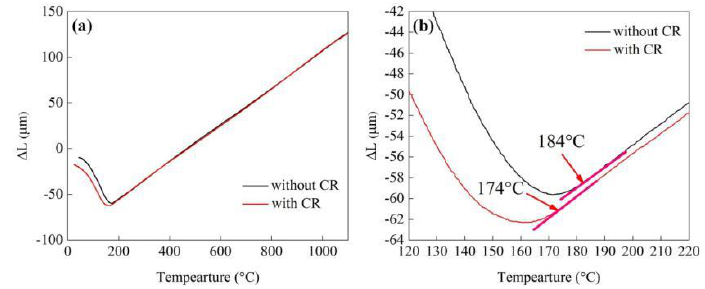
Figure 2. ( a ) Dilation versus temperature curves at the cooling rate of 10 °C/s; ( b ) magnification of ( a ) to determine the M s temperature.